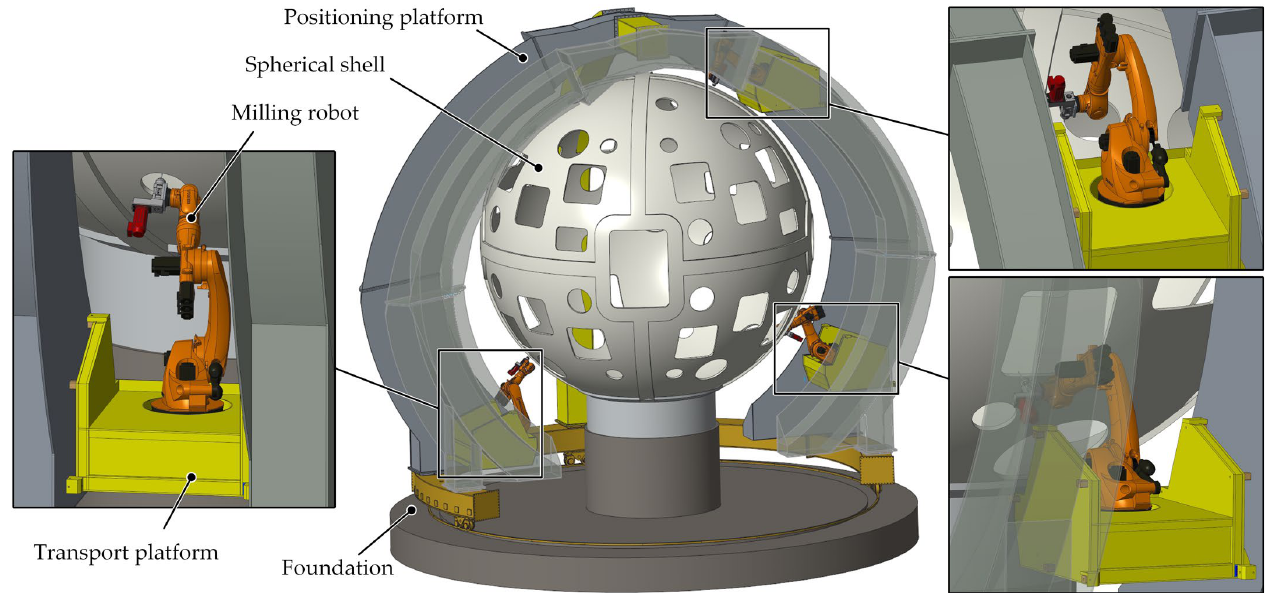
Figure 7. Diagram of the flexible machining system.